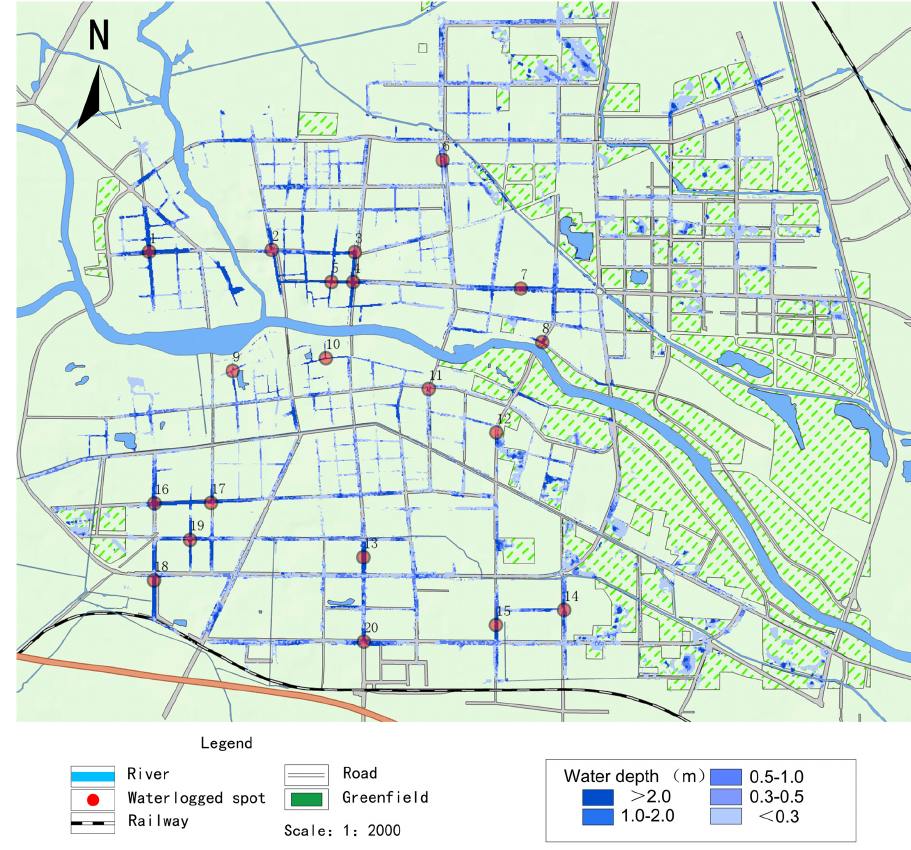
Figure 3. 2021.7.20 Distribution of major waterlogged sites. Table 1. 2021.7.20 Comparison of measured and numerically modeled ponding depths at inundated water